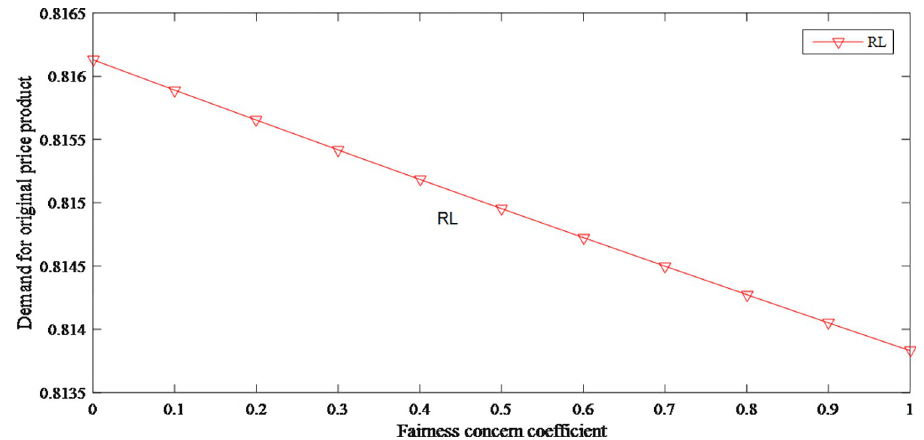
Fig 10. The impact of fairness concerns on demand for original price product.